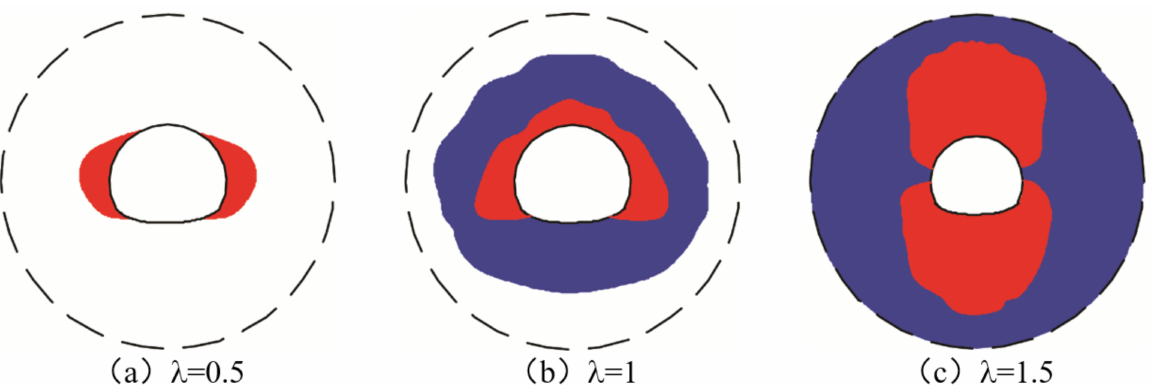
Figure 13. Range of strong and extremely strong rockburst in a double-track tunnel when σ v = 40